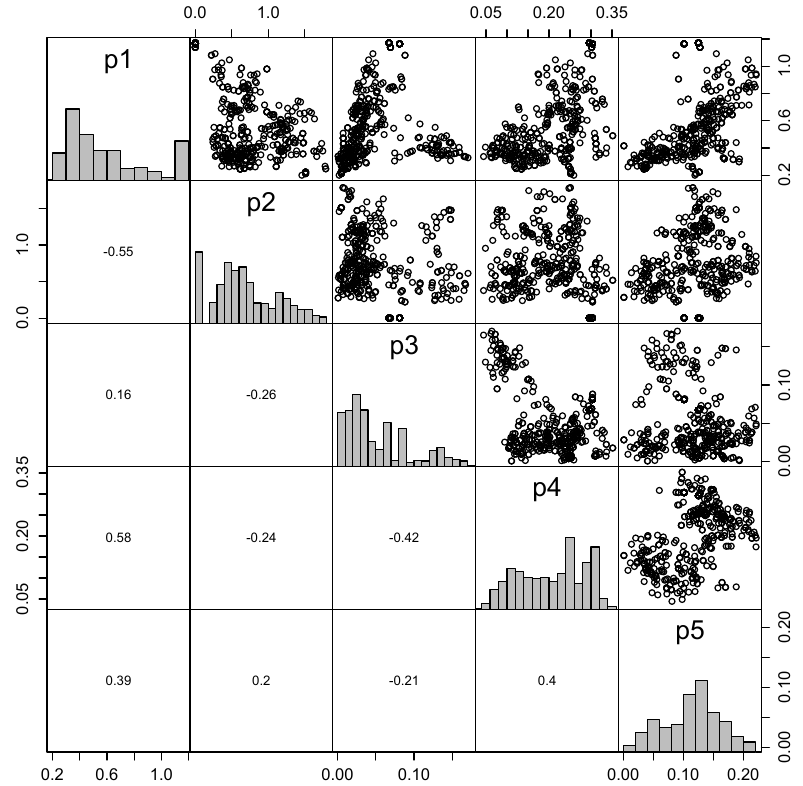
Figure 5. Posterior parameter distributions for the parameters of the model described by Eq. (21). p 1 = k 1 , p 2 = k 2 , p 3 = k 3 , p 4 = a 21 , p 5 = a 31 . Numbers in the lower diagonal indicate the correlation coefficient between parameters. Axes are presented in the range for each individual parameter, with units in yr − 1